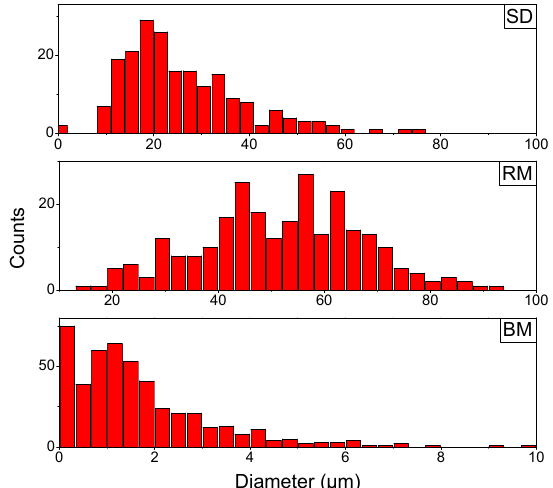
Figure 6. Particle Size Distribution (PSD) of the different processed samples. Spray-Dried ( SD ) sample at best parameter settings, Rotor Milled ( RM ) powder subjected to the three-step refinement process with final sieving step, and Ball Milled ( BM ) sample after 10 min (fractionated fine powder).